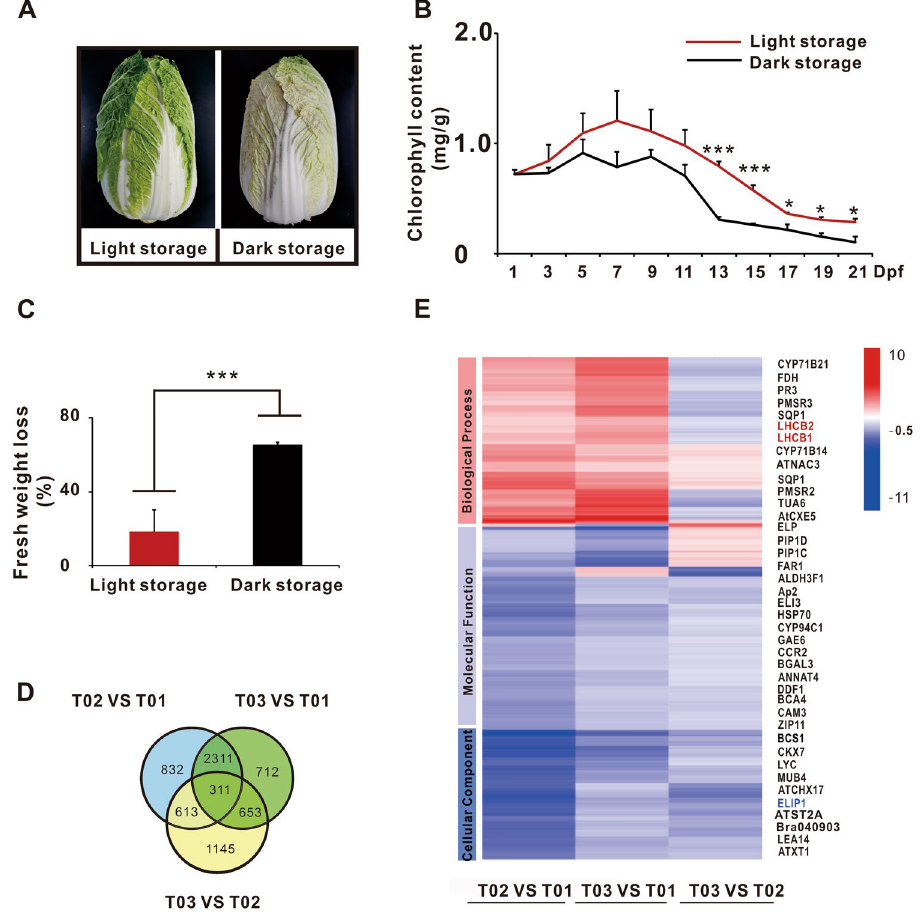
Figure 1. Screening for chlorophyll regulatory genes during the storage of Chinese cabbage. ( A ) Changes in appearance of Chinese cabbage. After 21 days, Chinese cabbage leaves under light storage condition were still green, but the leaves under dark storage condition lost most of their green pigment. ( B ) Chlorophyll content. Chlorophyll content was higher in light-stored samples than in dark-stored samples. ( C ) Percentage of fresh weight loss. Light-stored Chinese cabbage has a lower percentage fresh weight loss than the dark-stored ones after 21 days storage. ( D ) Venn diagram of DEGs. TS01 was fresh Chinese cabbage samples as control, TS02 was the 10th day Chinese cabbage samples under dark storage, and TS03 was the 20th day Chinese cabbage samples under dark storage. ( E ) Heat map showing up-regulated and down-regulated genes during the storage of Chinese cabbage. ELIP1, LHCB1, and LHCB2 are labeled on the right side of the heat map. Red color represents the up-regulated genes, and blue color represents the down-regulated genes. Asterisks indicate a significant difference compared to control negative as analyzed by Dunnett, one-way ANOVA. (* p < 0.05; ** p < 0.01; *** p < 0.001). All error bars are expressed as